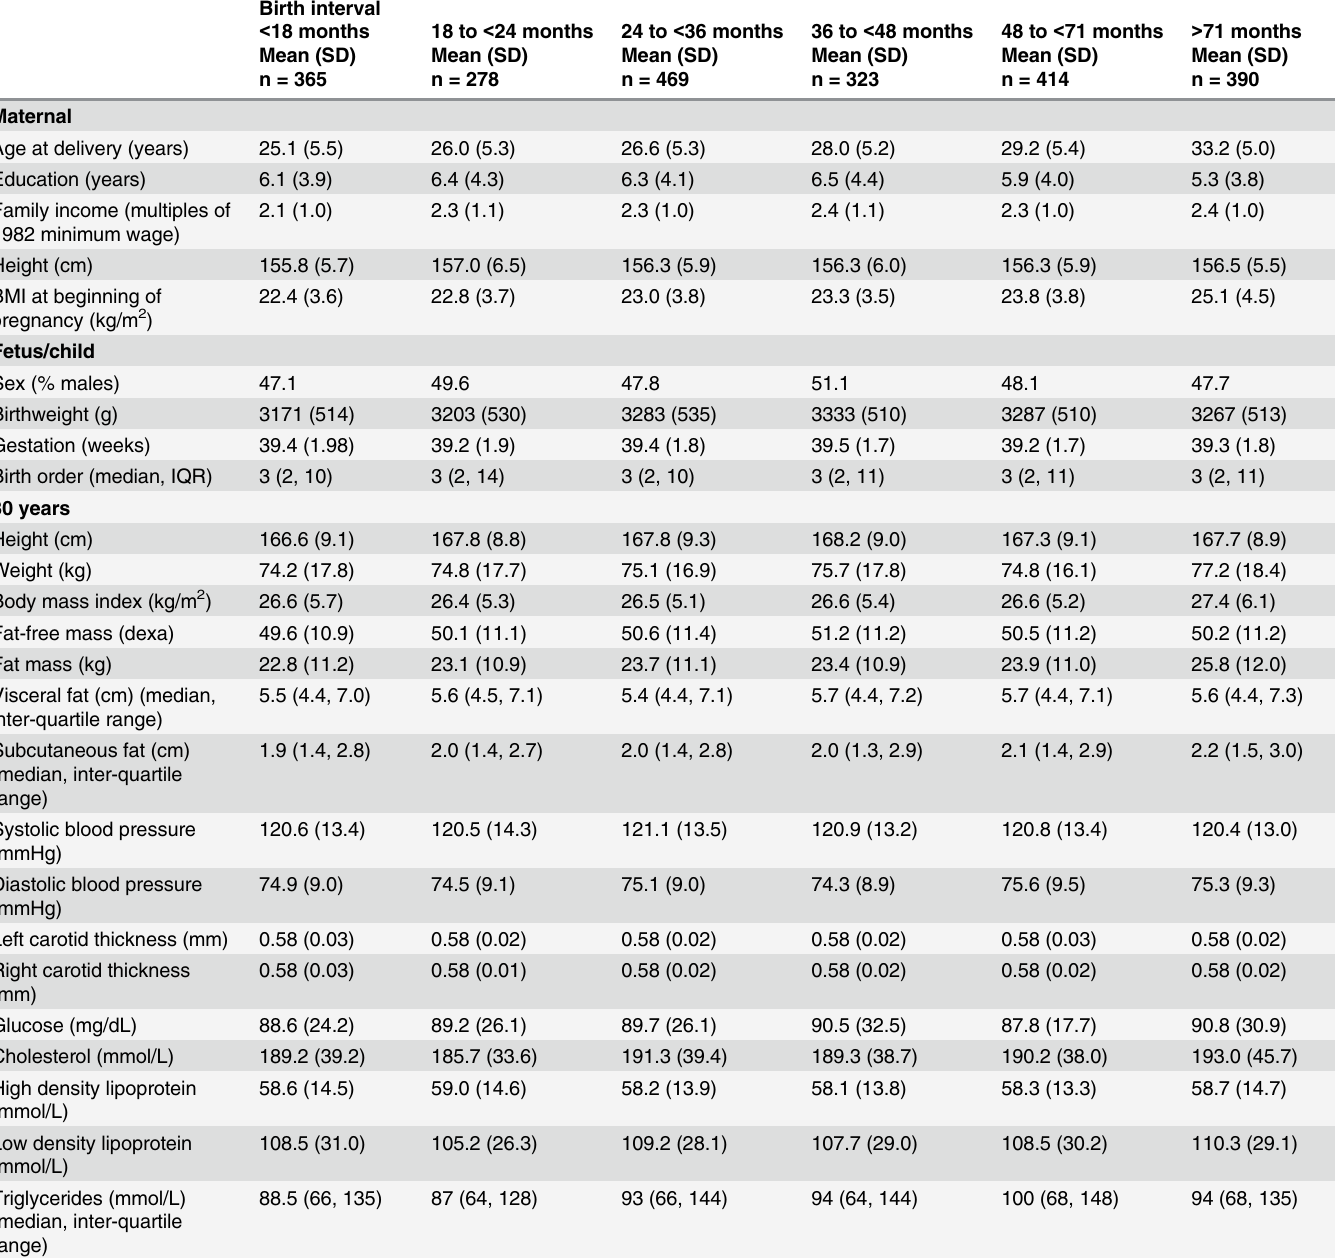
Table 1. Maternal and Offspring Characteristics at Birth and 30 years, Stratified by Birth Interval, for the 1982 Pelotas (Brazil) Birth Cohort. Birth interval < 18 months Mean (SD) n =